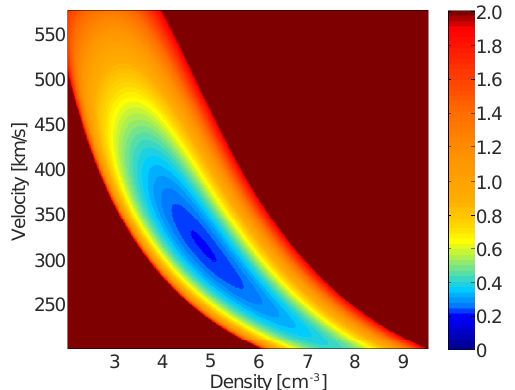
Figure 2. Color-coded value of the cost function with respect to solar wind velocity and density. The solar wind magnetic field and gas pressure is set to zero. The global minimum can be obtained using a gradient-based